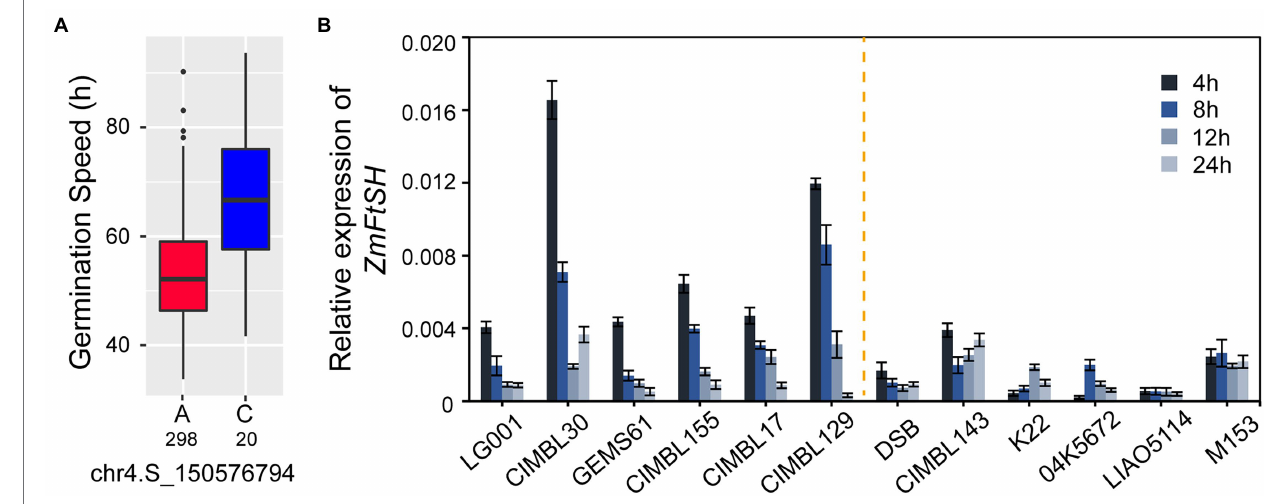
FIGURE 6 | Allele effect of SNP and expression patterns of ZmFtsH during seed germination. (A) Allele effect of SNP chr4.S_150576794 for GS, 298 and 20 are represent the number of A and C genotype in population, respectively. (B) The relative expression level of ZmFtsH at seeds imbibition 4, 8, 12, 24 h by qRT-PCR in